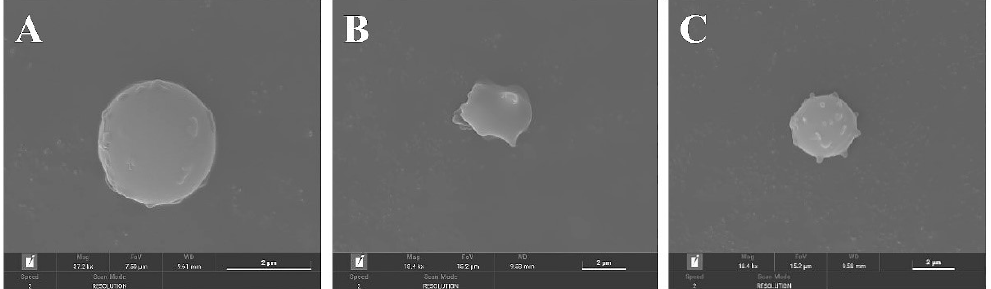
Figure 10. SEM micrographs of sheep erythrocyte samples: ( A ) normal erythrocyte; ( B ) AAPH-treated erythrocyte; ( C ) erythrocyte preincubated with diosmetin before AAPH treatment.